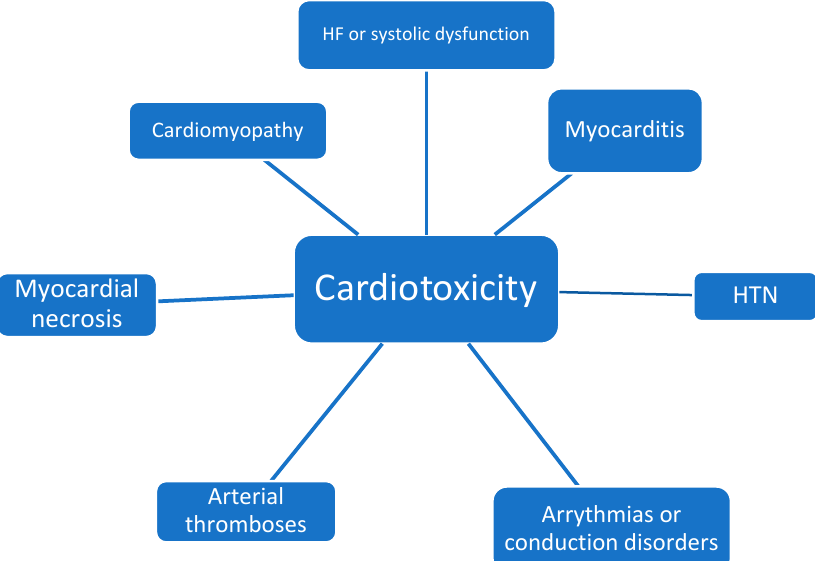
Figure 2. The most common cardiac complications of treatment with non-anthracycline agents.